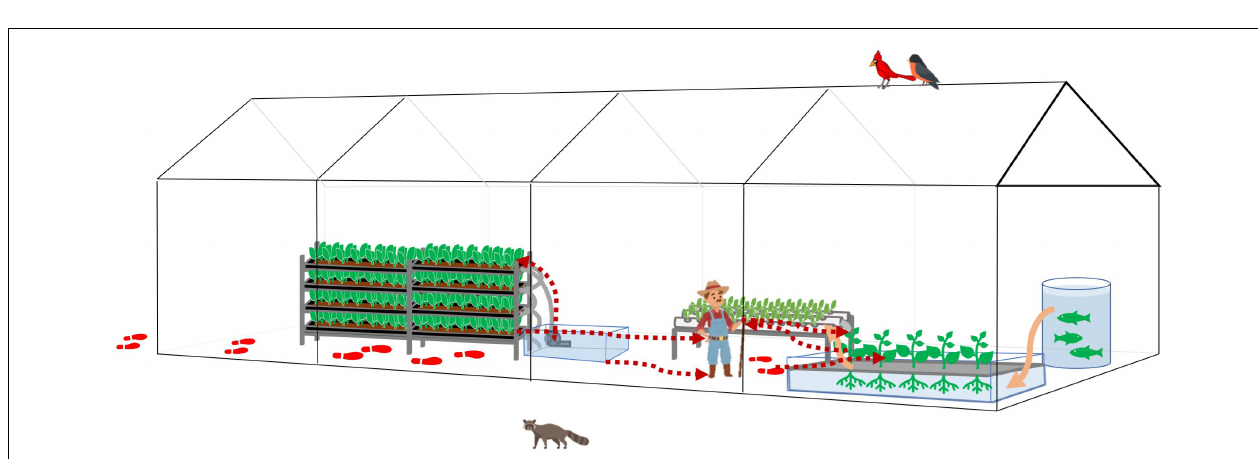
FIGURE 6 | Venn diagrams of microbiome overlapping between different sample types. (A) Microgreens overlap with farm H environment (left), with L1 system environment (mid), and farm H worker’s shoes and hands (right). (B) Lettuce overlaps with farm A environment (left), L2 system (mid), and farm A worker’s shoes (right). The numbers in each region represent the numbers of unique ASVs in that region.